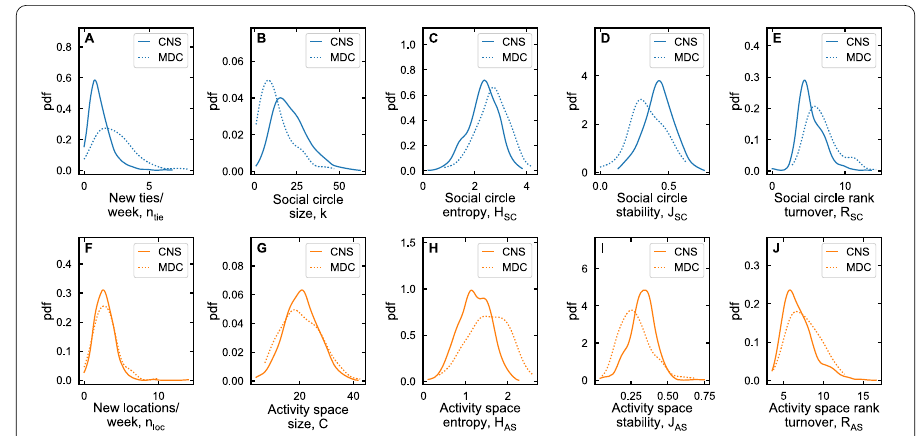
Figure 2 Distribution of social (above line) and spatial (bottom line) metrics for the CNS and MDC datasets